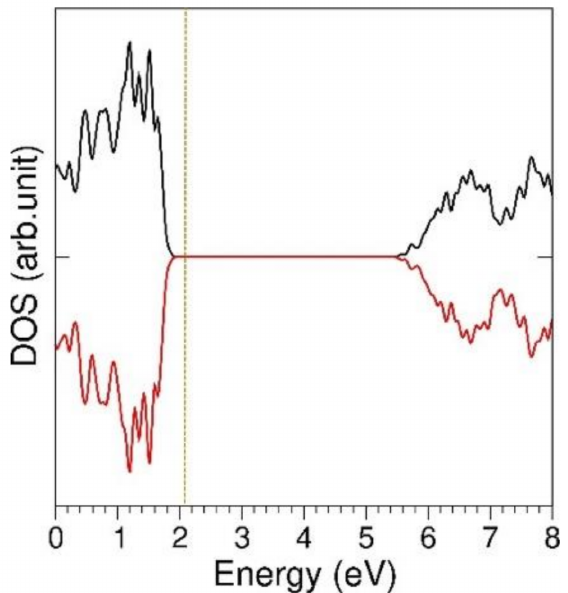
Figure 6. Total DOS plot of LZO. Vertical dot line corresponds to the Fermi energy